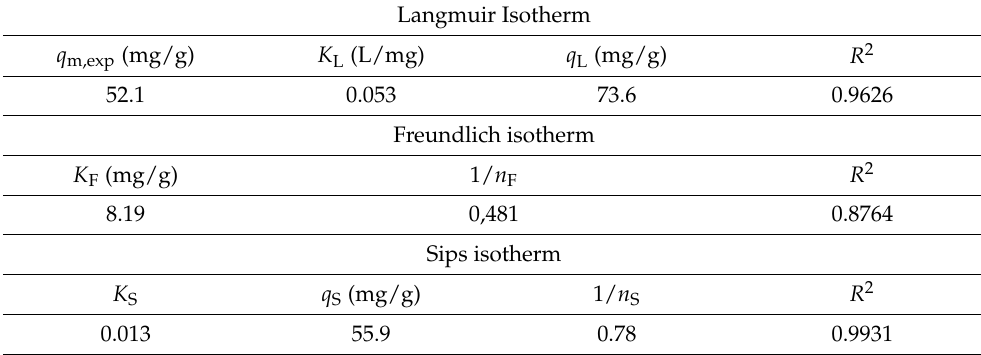
Table 4. Parameters of the isotherm model for adsorption of Ru(III) onto Ch-DB30C10.